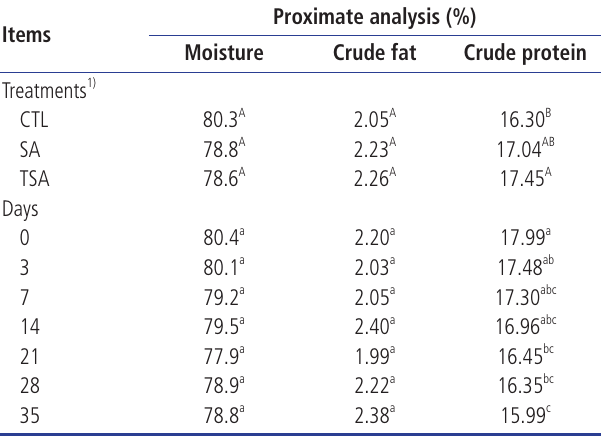
Table 2. Proximate composition low-fat pork sausages wrapped with film of SA and TSA Items